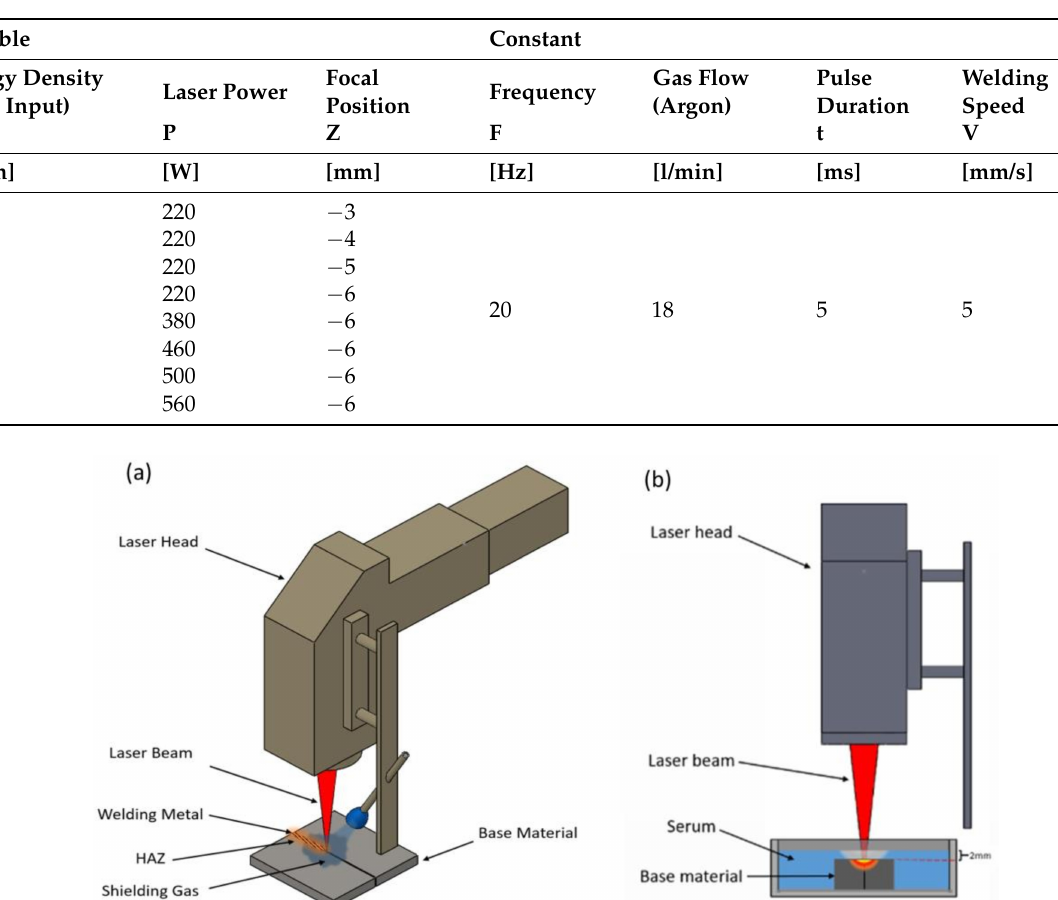
Table 2. Laser parameters used in the experiments. (Argon was used for air welding as the shield- ing gas.)